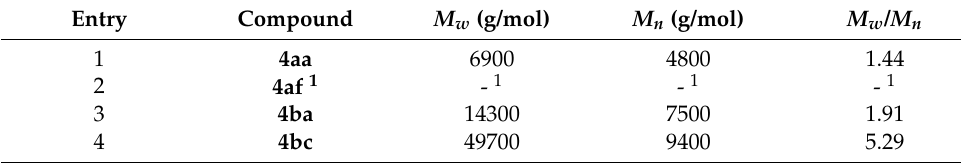
Table 2. Molar mass characteristics of the representative compounds 4aa , 4af , 4ba , and 4bc .